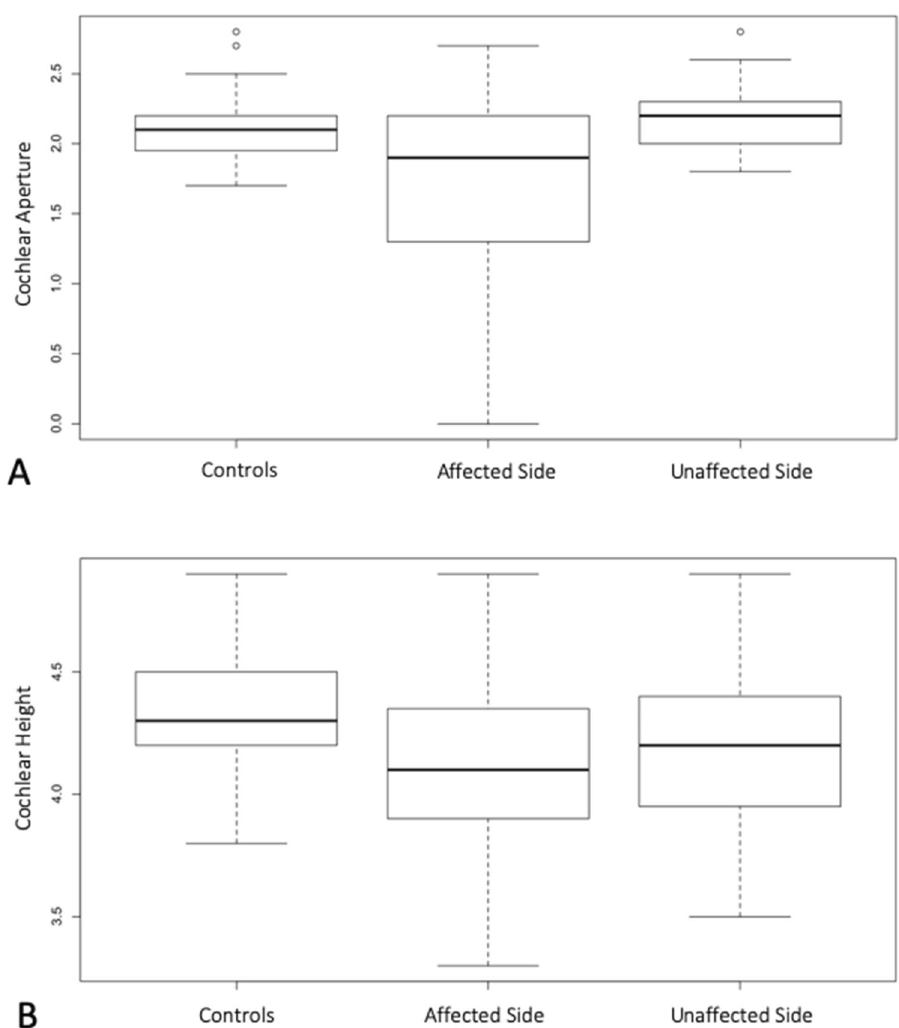
Figure 2. The box-plot A represents the comparisons of the cochlear aperture’s dimension in millimeters between normal controls, affected side, and unaffected side. The box-plot B represents the comparison of the cochlear height’s dimensions between the same groups. In the y-axis, the values represent the measurement in millimeters 35